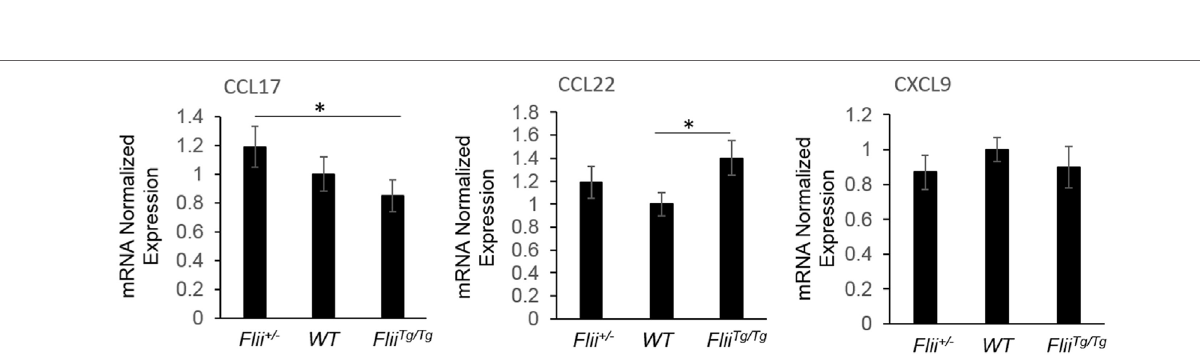
FigUre 3 | OVA-induced atopic dermatitis (AD) skin-like lesions of Flii -deficient mice exhibit increased anti-inflammatory cytokine levels. mRNA levels of Flii, pro-inflammatory, and anti-inflammatory cytokines responsible for manifestation of AD were analyzed in the OVA-induced AD skin-like lesions of Flii + / − , wild-type, and Flii Tg/Tg animals. OVA-induced AD skin-like lesions of Flii -deficient mice have significantly higher IFN- γ , reduced IL-4 signaling, and significantly higher levels of anti-inflammatory IL-10 while the Flii transgenic counterparts show significantly increased TNF- α and significantly reduced IFN- γ compared to wild-type animals. n = 6. Mean ± SEM. * <